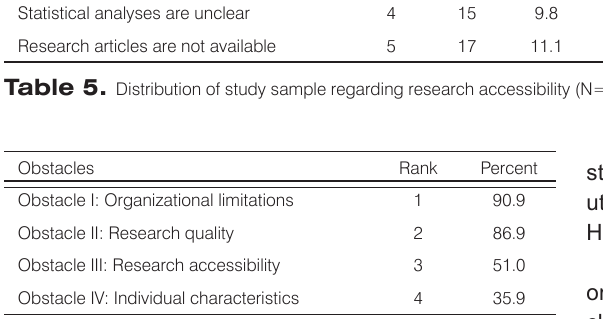
Table 6. Rank of obstacles and percentages of nurses who perceived them as high and